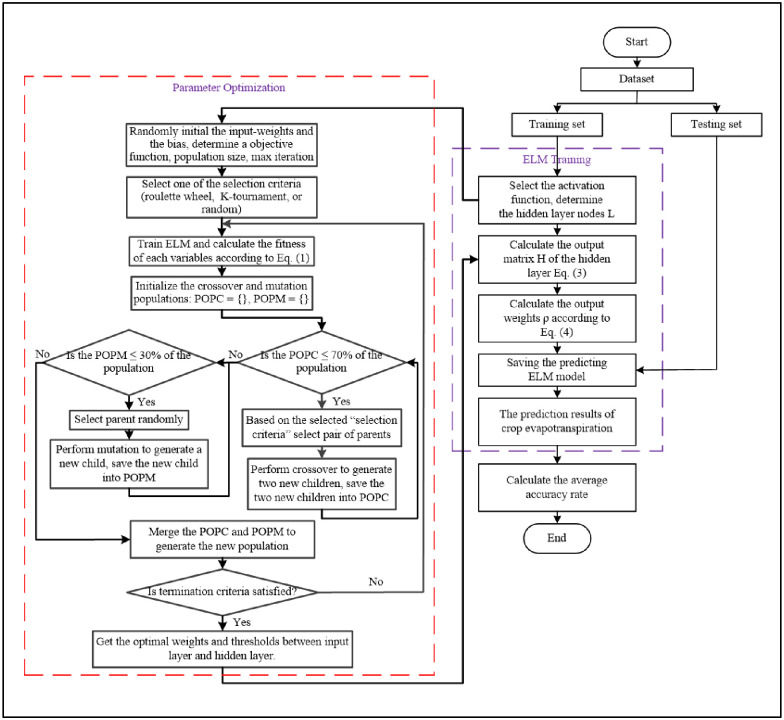
OGA-ELM’s flowchart [28].